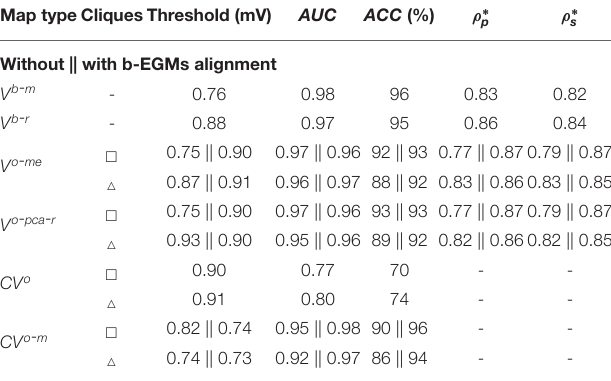
TABLE 1 | Fibrosis detection performance (voltage threshold, AUC and ACC), Pearson ρ p and Spearman’s ρ s correlations obtained from clean b-EGMs ( σ n = 0 µ V ), by considering jointly the three MEA orientations with respect to the propagation direction.